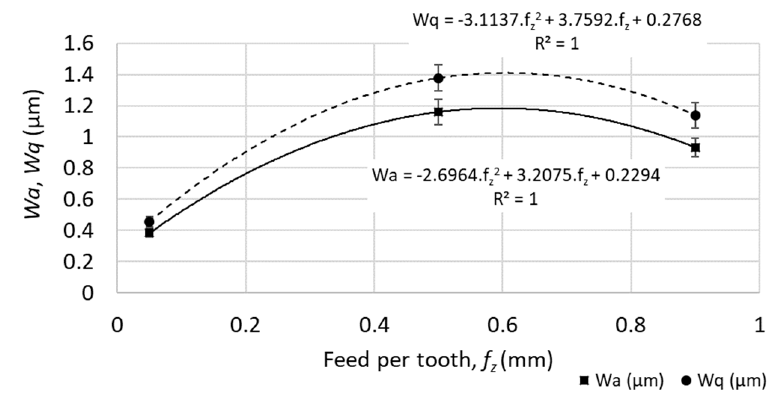
Figure 9. Example of profile waviness parameters ( Wa— average waviness of the profile, Wq —root-mean-square waviness of the profile) for di ff erent feed speeds (at feed per tooth v c = 200 m.min − 1 ). The parameter R 2 reflects the level of statistical correlation.